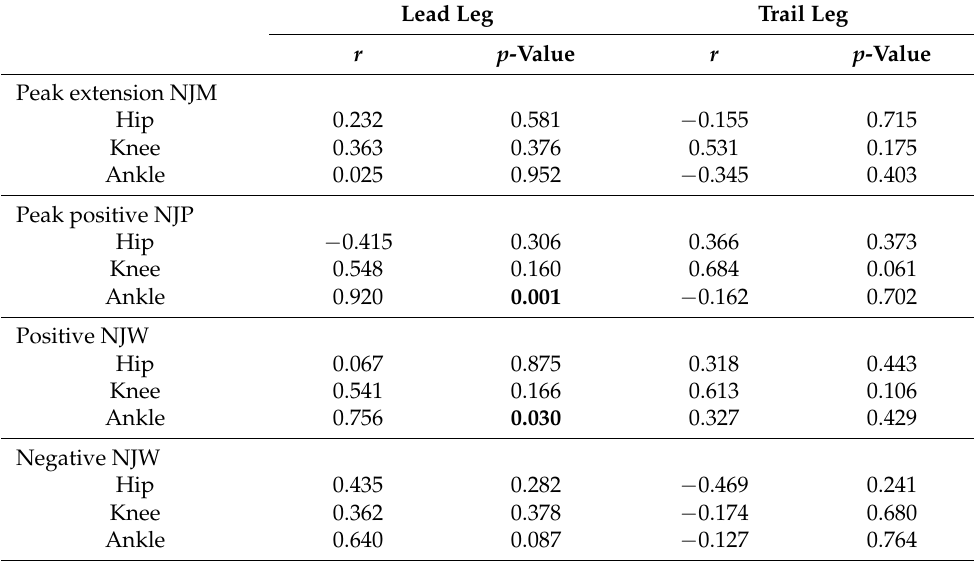
Table 3. Correlations between joint-level biomechanical parameters of the countermovement jump and the lead and trail legs of the preferred-style jump. Lead Leg Trail Leg r p -Value r p -Value Peak extension NJM Hip